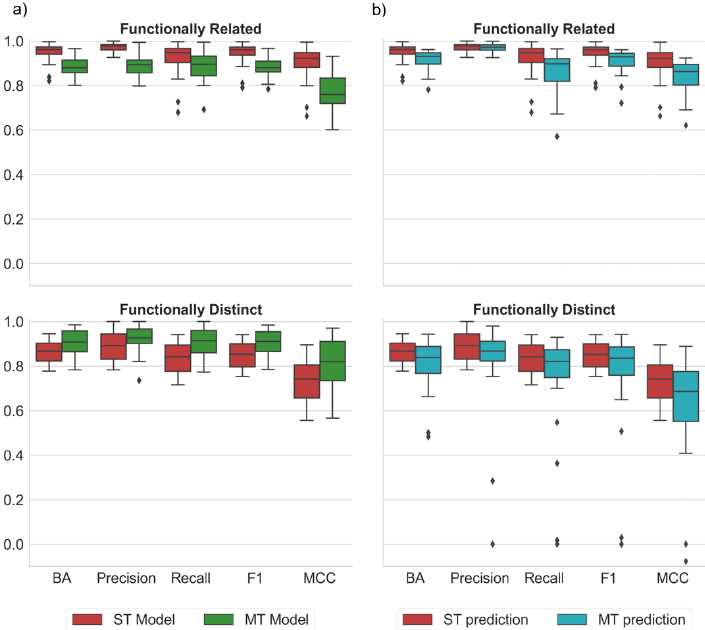
Figure 1. Performance of RF models for ST- and MT-CPD prediction. Boxplots report the distributions of different performance measures for predictions on all target pairs averaged over 10 independent trials. Performance measures included balanced accuracy (BA), precision, recall, F1, and Matthews correlation coefficient (MCC). Compounds with activity against pairs of functionally related or distinct targets were predicted. ( a ) ST model (red), trained for classification of randomly chosen vs. ST-CPDs; MT model (green), trained for classification of ST- vs. MT-CPDs. ( b ) ST model, applied to classify randomly chosen vs. ST-CPDs (same as in ( a ), red) and randomly chosen vs. MT-CPDs (cyan). In boxplots, diamond symbols represent statistical